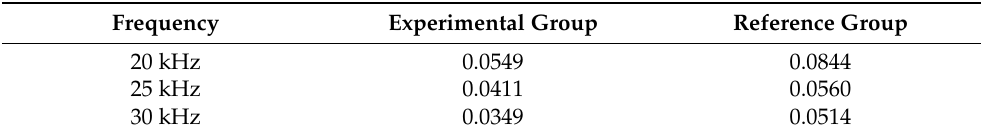
Table 7. Variances of concentration with different frequencies.